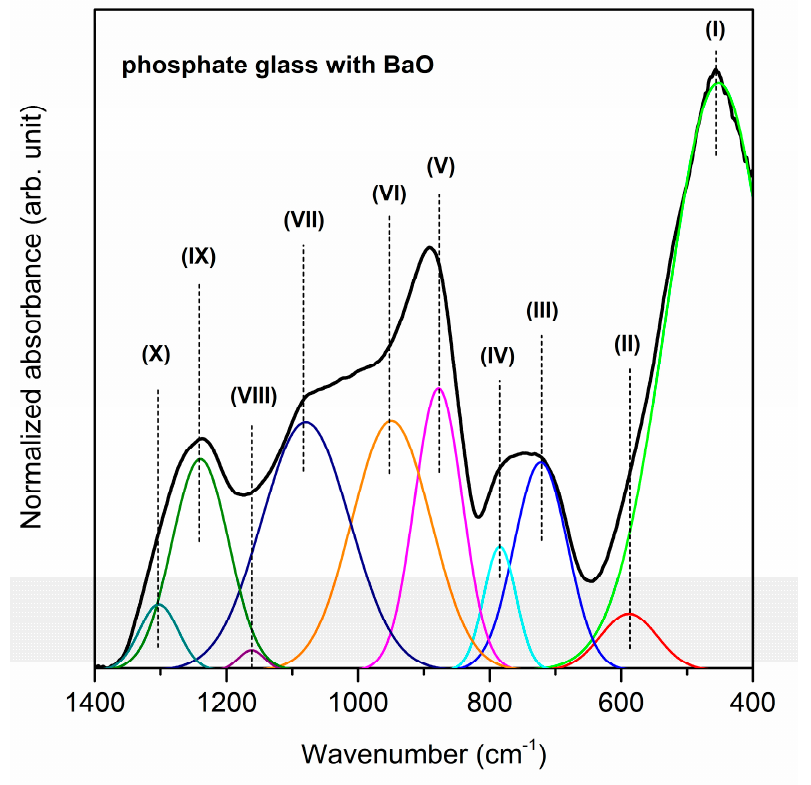
Figure 3. Deconvoluted near-infrared spectra of phosphate glass with BaO as oxide glass modifier.